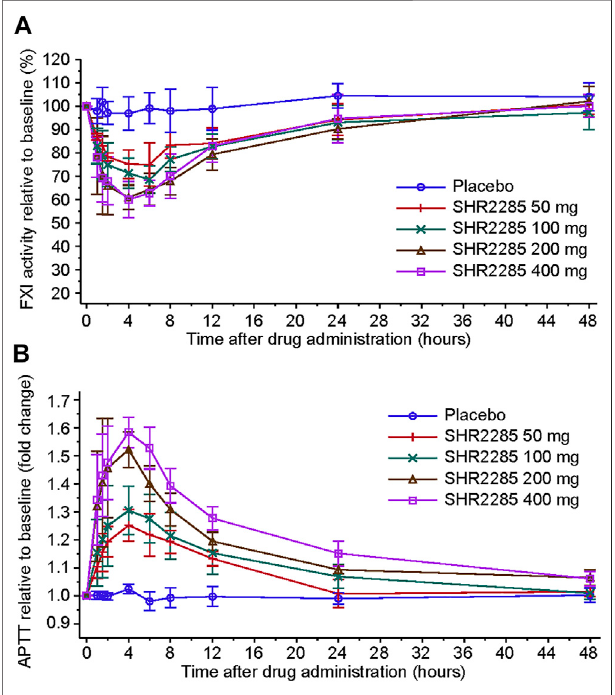
FIGURE 3 | Effects of increasing doses of SHR2285 on FXI (A) and APTT (B) in healthy